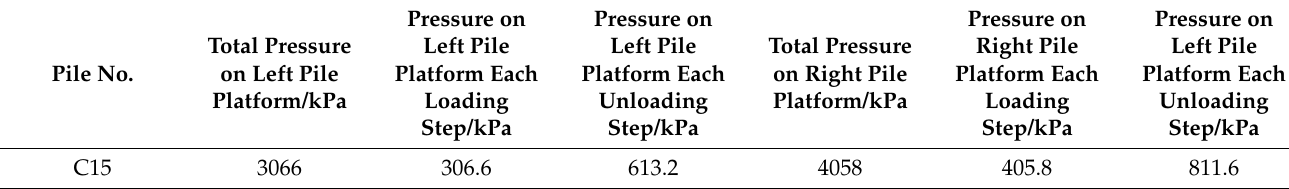
Table 3. Equivalent jacking pressures applied on the pile platforms.